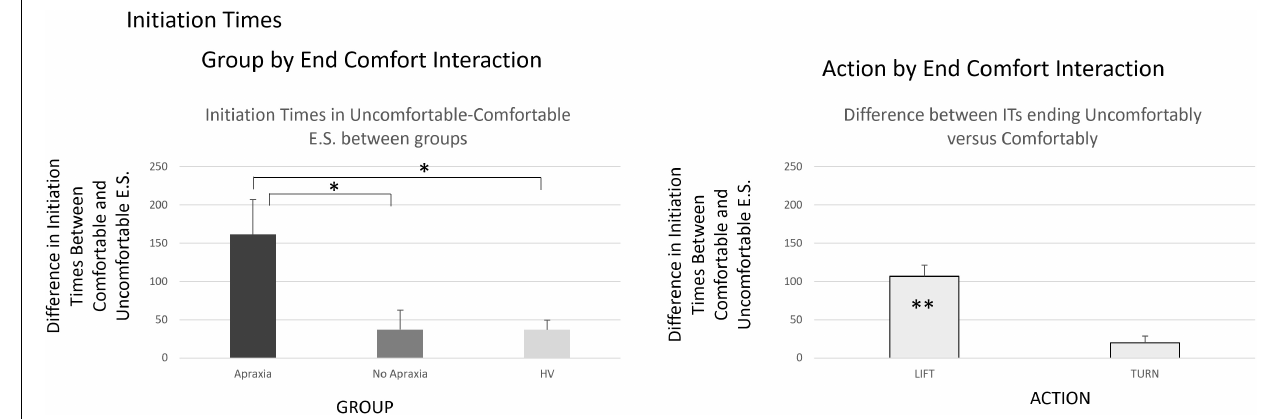
FIGURE 3 | Initiation times – interactions by group. The group by end-comfort interaction in the left panel indicated that initiation times for actions that ended uncomfortably were longer than those for the ones that ended comfortably, particularly in patients with ideomotor apraxia, compared to patients without apraxia and healthy volunteers. The action by end-state comfort interaction indicated in the right panel was due to prolonged initiation times for actions ending uncomfortably in lift actions, when there was no significant difference in initiation times for turn actions whether they ended comfortably or not. ∗ p < 0.05, ∗∗ p <